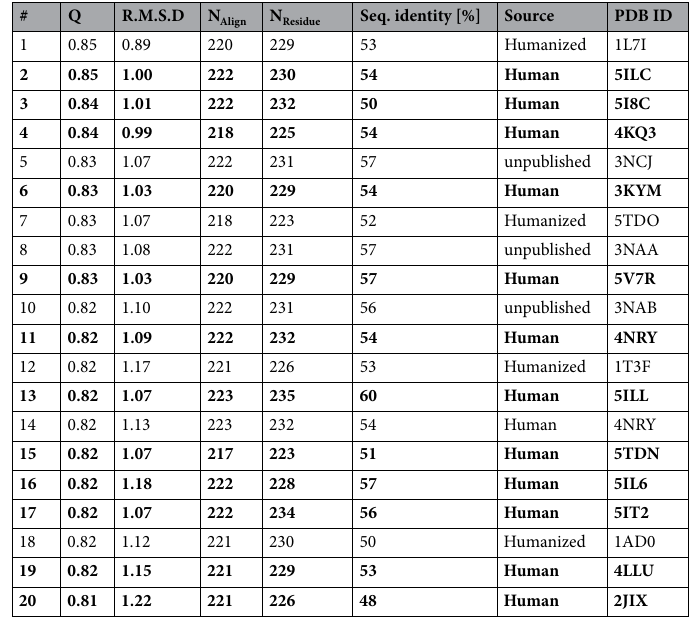
Table 3. List of human Fv fragments from the AbDB 22 with high structural similarity to the V-regions of Fab M3/38 based on an alignment with PDBeFold 21 . This analysis was performed with a coordinate set at a preliminary stage of refinement (R cryst = 20.7%/R free = 25.1%). Q mean square deviation weighted by the length of the alignment, N Align ; N Residue total number of amino acid residues in the sequence; R.M.S.D . root mean square